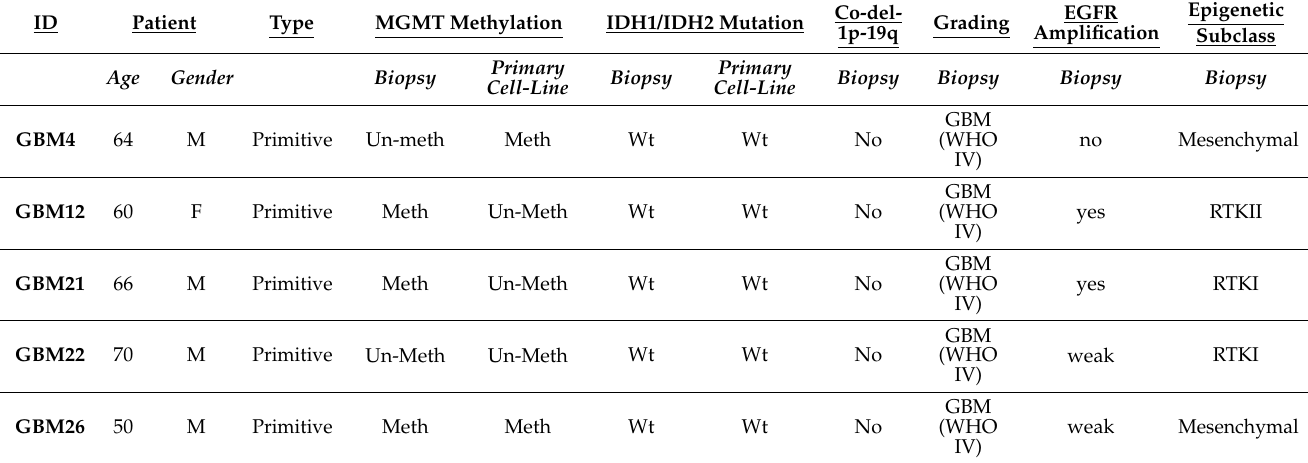
Table 1. Patients and primary cell line characterization: Genetic and epigenetic profile of tissues obtained by surgery compared with derived primary cells. MGMT methylation status, IDH1 and IDH2 mutation status, and evaluation of co-deletion 1p–19q were extrapolated from the EPIC (850 K) Methylome Array. The data were confirmed by independent techniques, used as gold standard. Epigenetic sub-class was obtained comparing sample methylome profile with samples present in TGCA database bank. Epigenetic subclasses indicate mesenchymal GMB as a gliosarcoma; RTKI as a proneural tumor; RTKII as a classical or neural tumor. Integrated genomic analysis identifies clinically relevant subtypes of glioblastoma characterized by abnormalities in PDGFRA, IDH1, EGFR, and NF1. Cancer Cell 17, 98–110